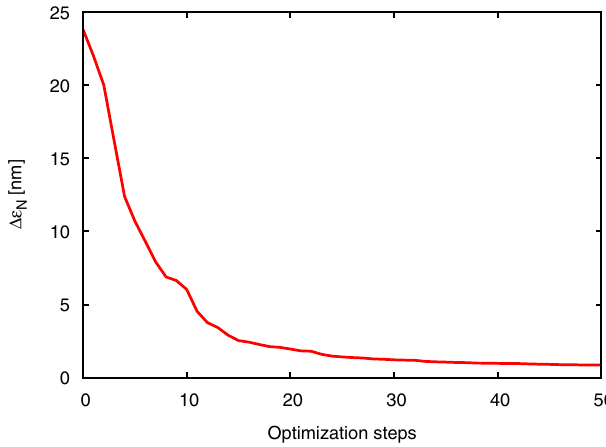
FIG. 4. Average emittance growth for 100 CLIC main linacs. The emittance growth is seen to decrease for each optimization step. Such an optimization step corresponds to the tuning of a single knob. In total ten knobs, each controlling the vertical displacement of an accelerating structure in the CLIC main linac, were used. Three or more iterations of the ten knobs seem to be needed for convergence.